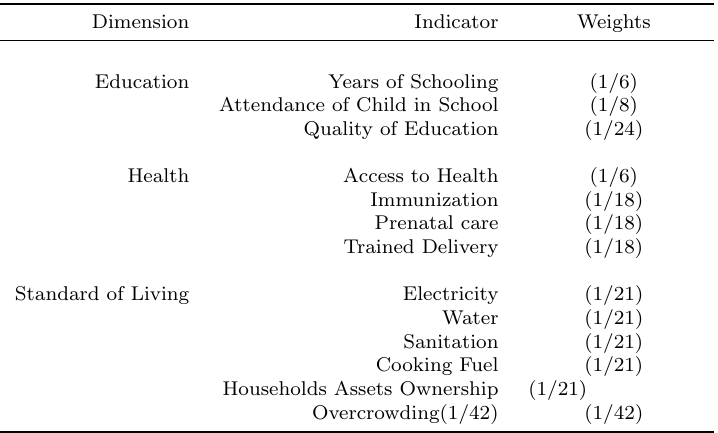
Table 1: Indicators and Weights used to Develop